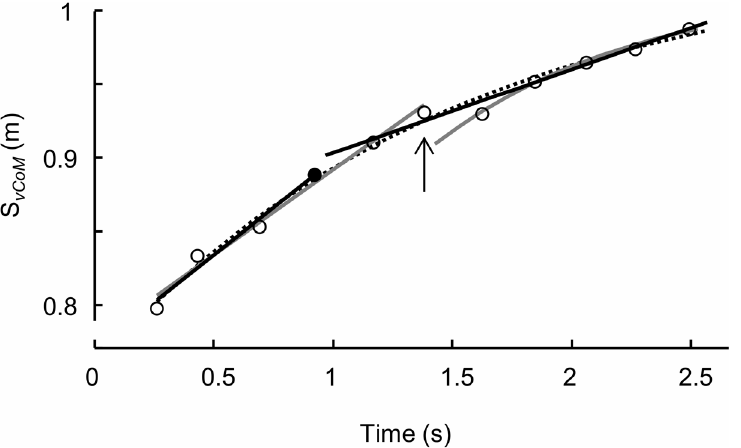
Fig 2. Example of CoM ’ s vertical position and curve fitting from step to step in time. Open markers are data, solid marker indicates the breakpoint according to Nagahara et al. [10] and piecewise twice linear fit (solid lines, Eq 5a). Vertical arrow indicates the breakpoint according to linear-exponential piecewise fit (grey curves, Eq 5b). Dotted line is exponential fit (Eq